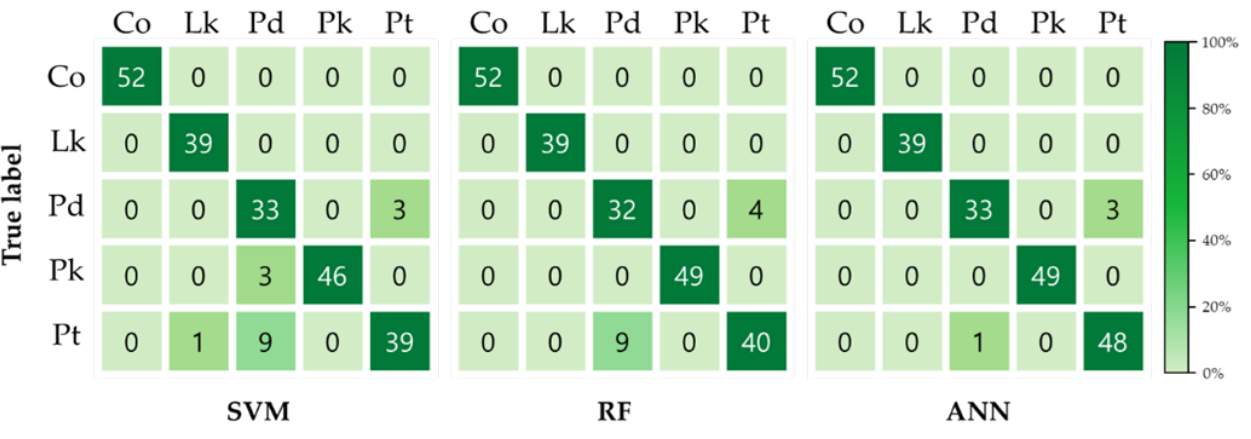
Table 1. Classification accuracies for training, test, and new test set data for each machine learning model.